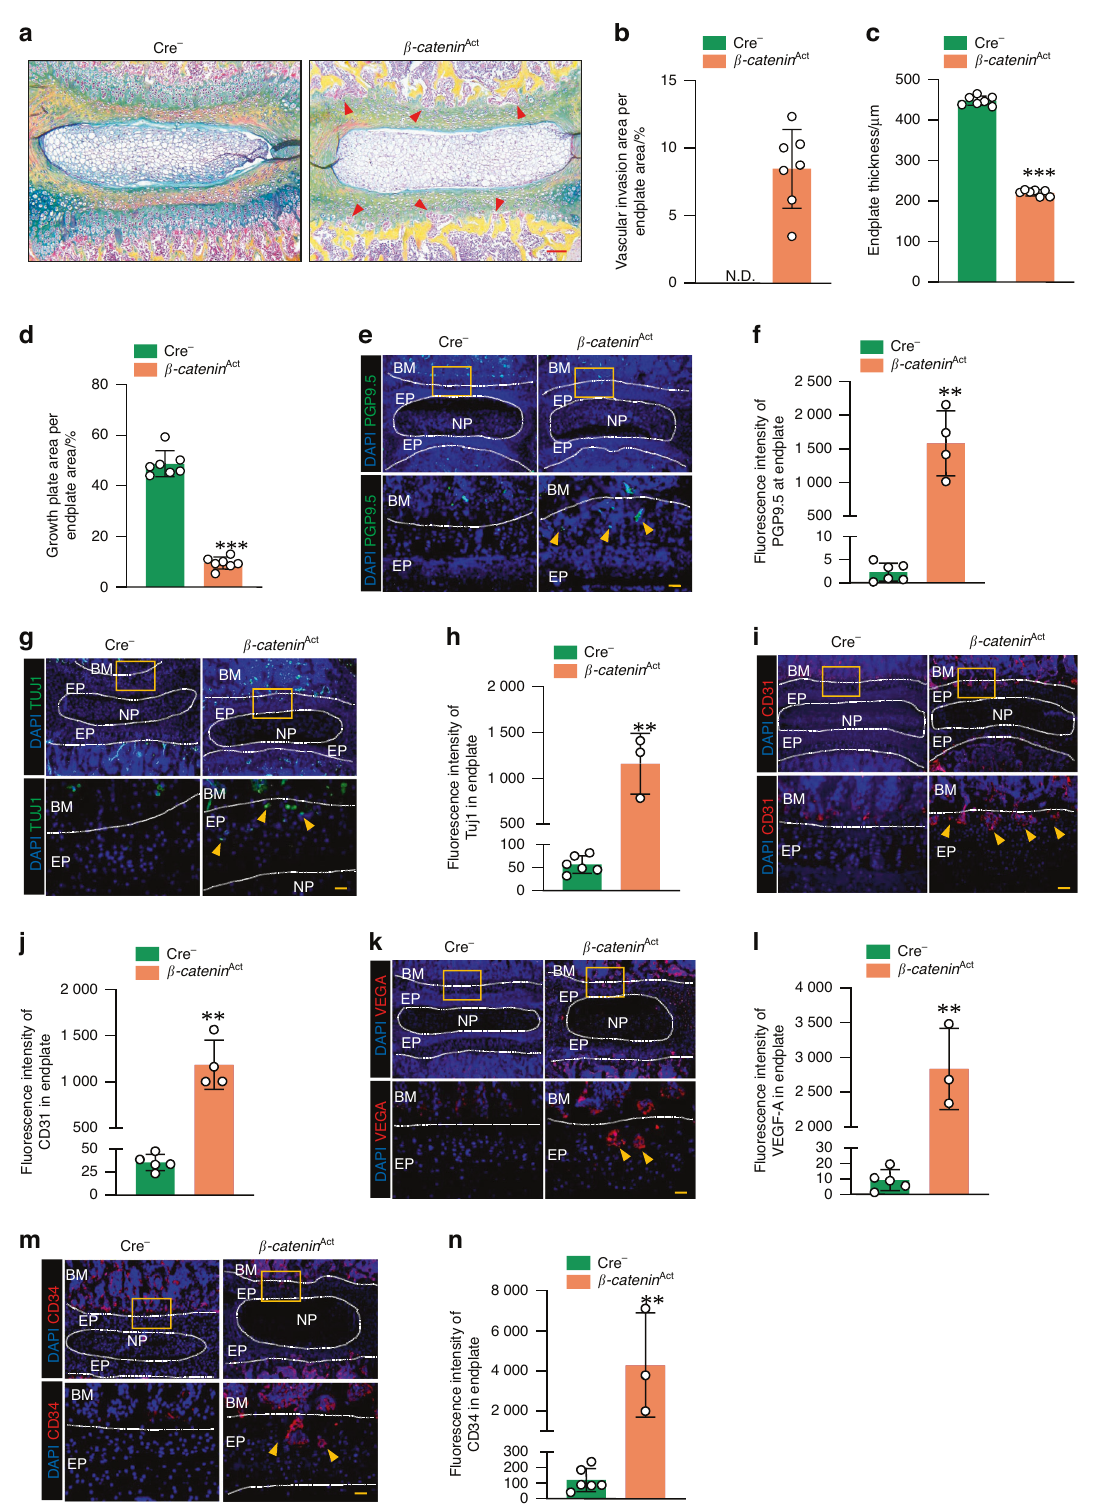
Fig. 3 Vascular invasion and nerve ingrowth at the endplate area of the IVD in β -catenin activation transgenic mice. a Representative Alcian blue/hematoxylin & Orange G staining (scale bar 100 μ m) to visualize blood vessel invasion and new woven bone formation in 5-week-old β -catenin Act mice and their Cre − littermates ( n = 7). b – d Histological analysis to measure vascular invasion ( b ), endplate thickness ( c ) and growth plate area ( d ) in 5-week-old β -catenin Act mice and their Cre − littermates ( n = 7). e – n Representative IF images (scale bar 25 μ m) visualizing PGP9.5 ( e , f ), TUJ1 ( g , h ), VEGF-A ( i, j ), CD31 ( k , l ) and CD34 ( m , n ) expression at the endplate area in 5-week-old β -catenin Act mice and their Cre − littermates (Cre − : n = 6, β -catenin Act : n = 3 or 4). Arrowheads indicate a positive IF signal in the endplate area in β -catenin Act mice. BM: bone marrow, EP endplate, NP nucleus pulposus. * P < 0.05; ** P < 0.01; *** P < 0.001. Data are represented as the mean ± SD. Two- tailed unpaired Student ’ s t test analysis ( b – d , f , h , j , l , n